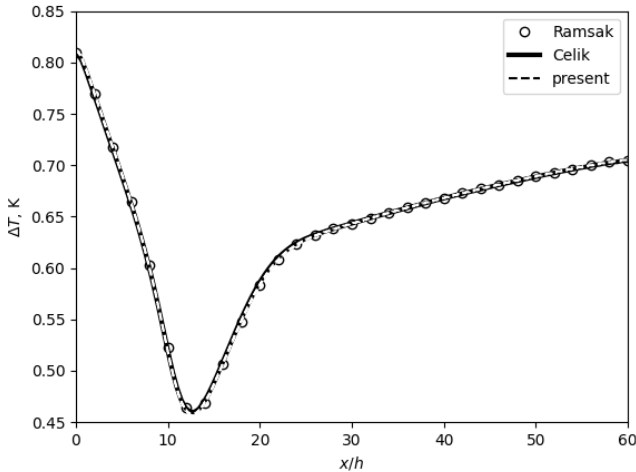
Figure 6. Comparison of temperature profiles at the fluid-solid interface. with further increases in this distance. The mesh was uniform with edge length equal to 122 one-twentieth of the channel height. Simulations with half the cell edge length showed 123 differences of less than 0.1 percent. Initial simulations of the hydraulics at Re = 800 were performed using pimpleFoam , 125 and it was found that the computed separation and reattachment points were in good 126 agreement with earlier studies: the reattachment point on the lower wall, x 1 / h = 12.2, 127 compared with 12.22 reported by Gartling [13] and 12.2 by Ramšak [14]; the separation 128